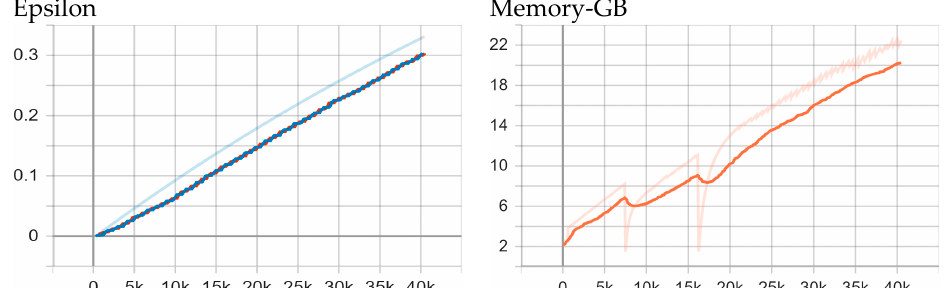
Figure 8. The average achieved epsilon score (Epsilon, left ) and used replay memory (Memory-GB, right ) value during the training process (red—target and blue—DQN value loss in epsilon graph; orange—used replay memory unit in GB). Epsilon graph shows the balances exploration and exploitation by choosing randomly in y axes that refers to the probability of choosing to explore, while x axes depict the training epochs. The memory graph represents the used memory space during training in the y axes as well as training epochs in the x axes.